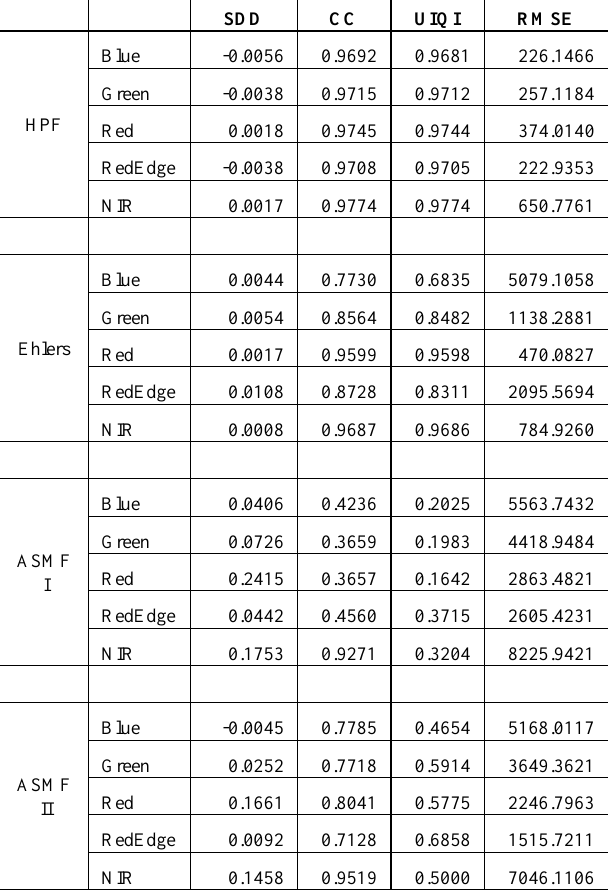
Table 2. Results of quality